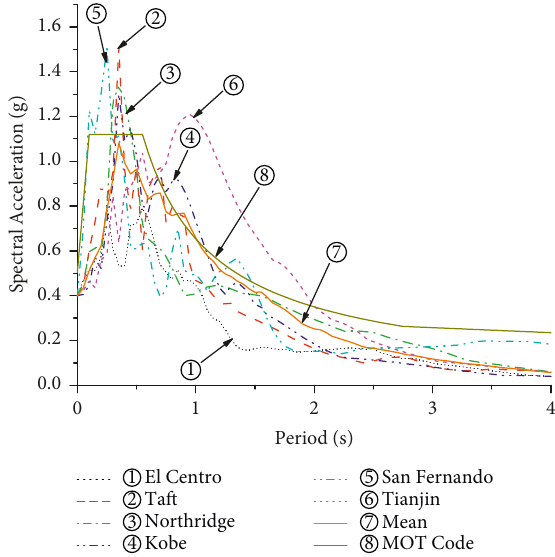
Figure 4: Acceleration response spectrum of the selected ground motions scaled for acceleration of 0.4 g. Table 2: Scale factors used to scale the ground motions. Ground